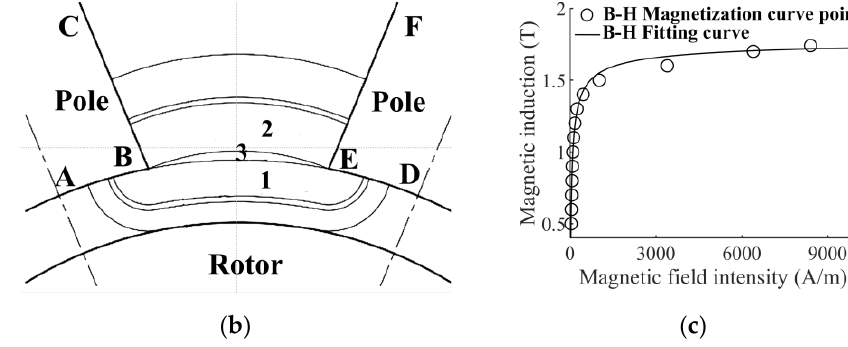
Figure 4. Each reluctance calculation by using NMCM. ( a ) The air gap reluctance model; ( b ) the leakage reluctance model; ( c ) the magnetization curve points of soft magnetic materials and their fitting curve.